Question: Express in one sentence what the figure is showing.
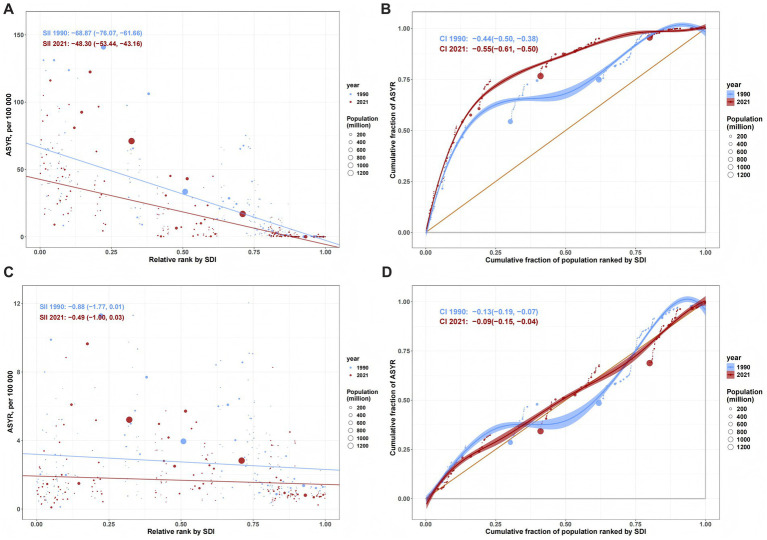
Answer: Absolute and relative cross-country inequalities in the ASYR of cataract attributable to HAP (A, B) and smoking (C, D) , 1990–2021. (A, C) Health inequality regression curves. (B, D) Concentration curves. ASYR, age-standardised YLD rate; HAP, household air pollution; SDI, Socio-demographic Index.